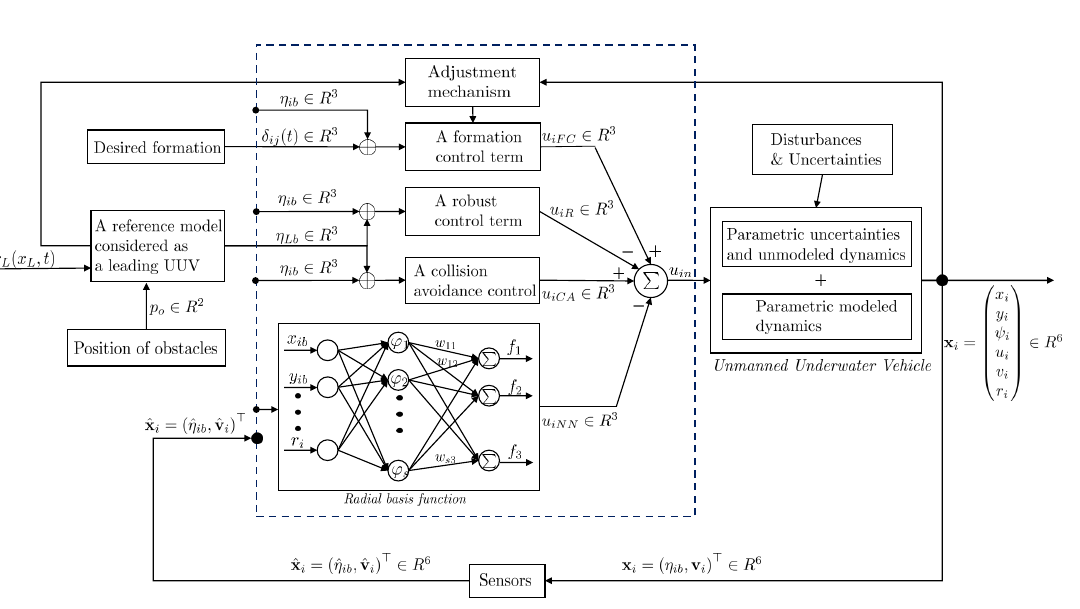
Figure 2. The overall distributed adaptive neural networks formation tracking control with collision and obstacle avoidance for the UUV